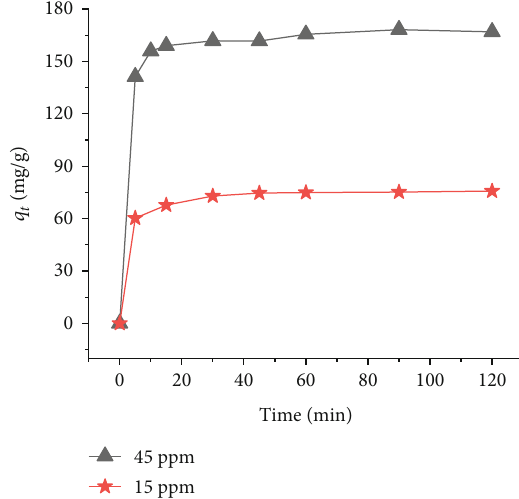
Figure 3: E ff ect of contact time on the adsorption of CV onto